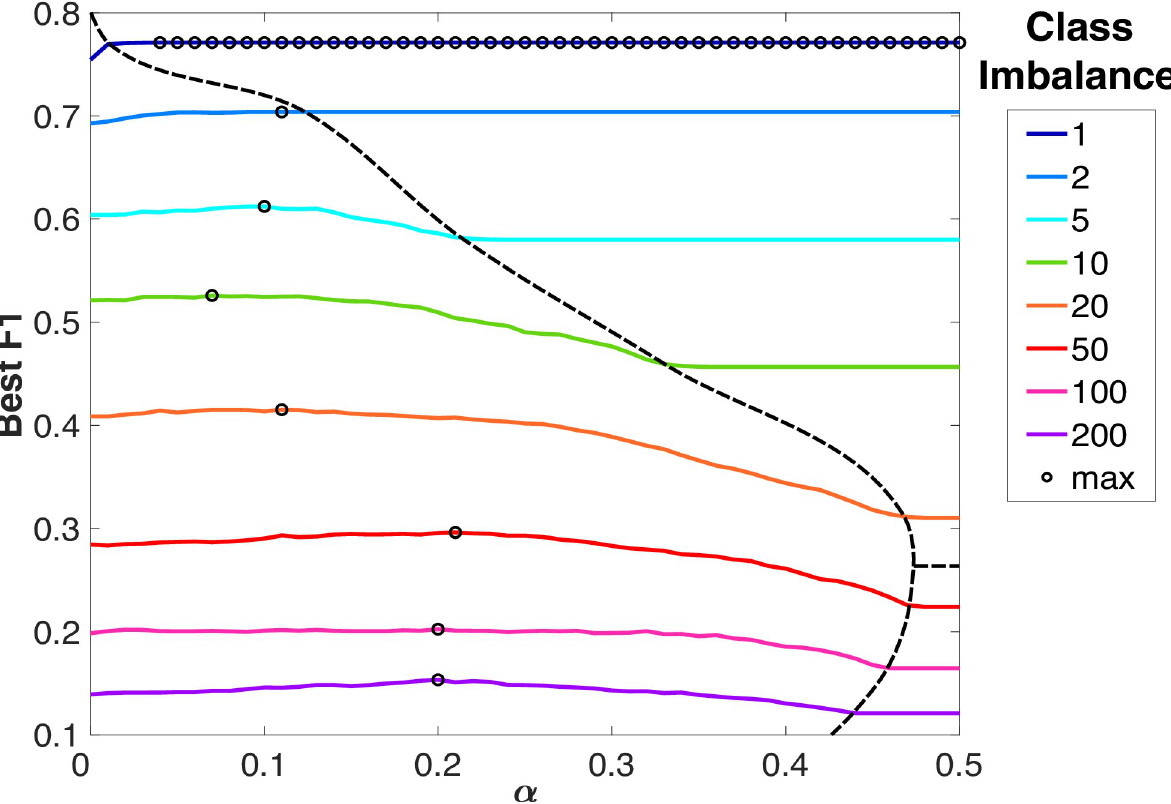
Fig 4. Behavior of Best F1 versus α for various class imbalance values in the Jaffe + sectors measure. Due to the correlation between Best F1 and class imbalance the various curves never intersect. In this plot, three phases divided by dotted lines can be spotted: a Low α phase, at the bottom-left, where there exists an α -dependent maximum for the Best F1, a High α —Low-class imbalance phase, at the top-right, and the High α —High-class imbalance phase at the bottom-right, where the Best F1 is independent of α .